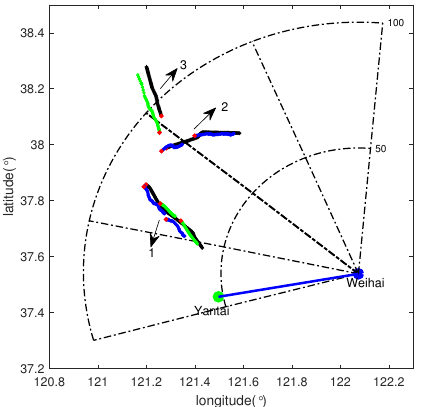
Figure 3. Tracking results of three typical targets. The blue and green dots indicate the location of the monostatic HFSWR at Weihai and the bistatic HFSWR at Yantai, respectively. The black angular sector illustrates the detection region of the monostatic HFSWR at Weihai. The three targets are marked as ‘1’, ‘2’, and ‘3’ and named as target 1, target 2, and target 3, respectively. The tracks in blue, green, and black represent the tracking results from the monostatic radar, bistatic radar, and matched AIS, respectively. The red dot indicates the first plot of a